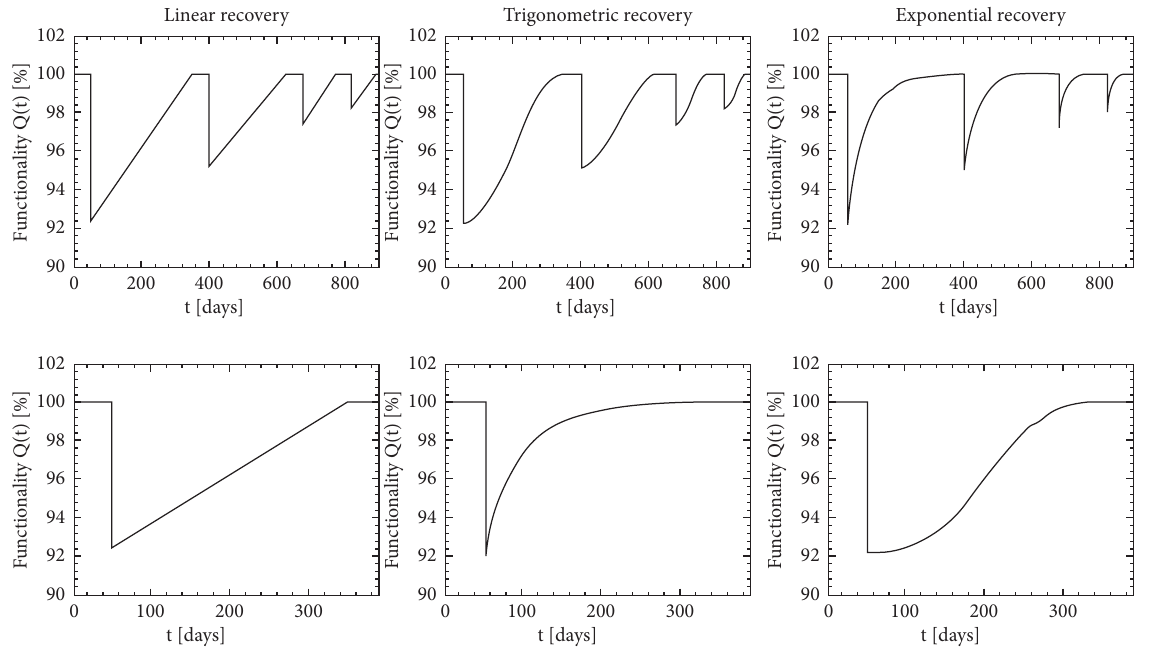
Figure 6: Examples of three types of functionality curves